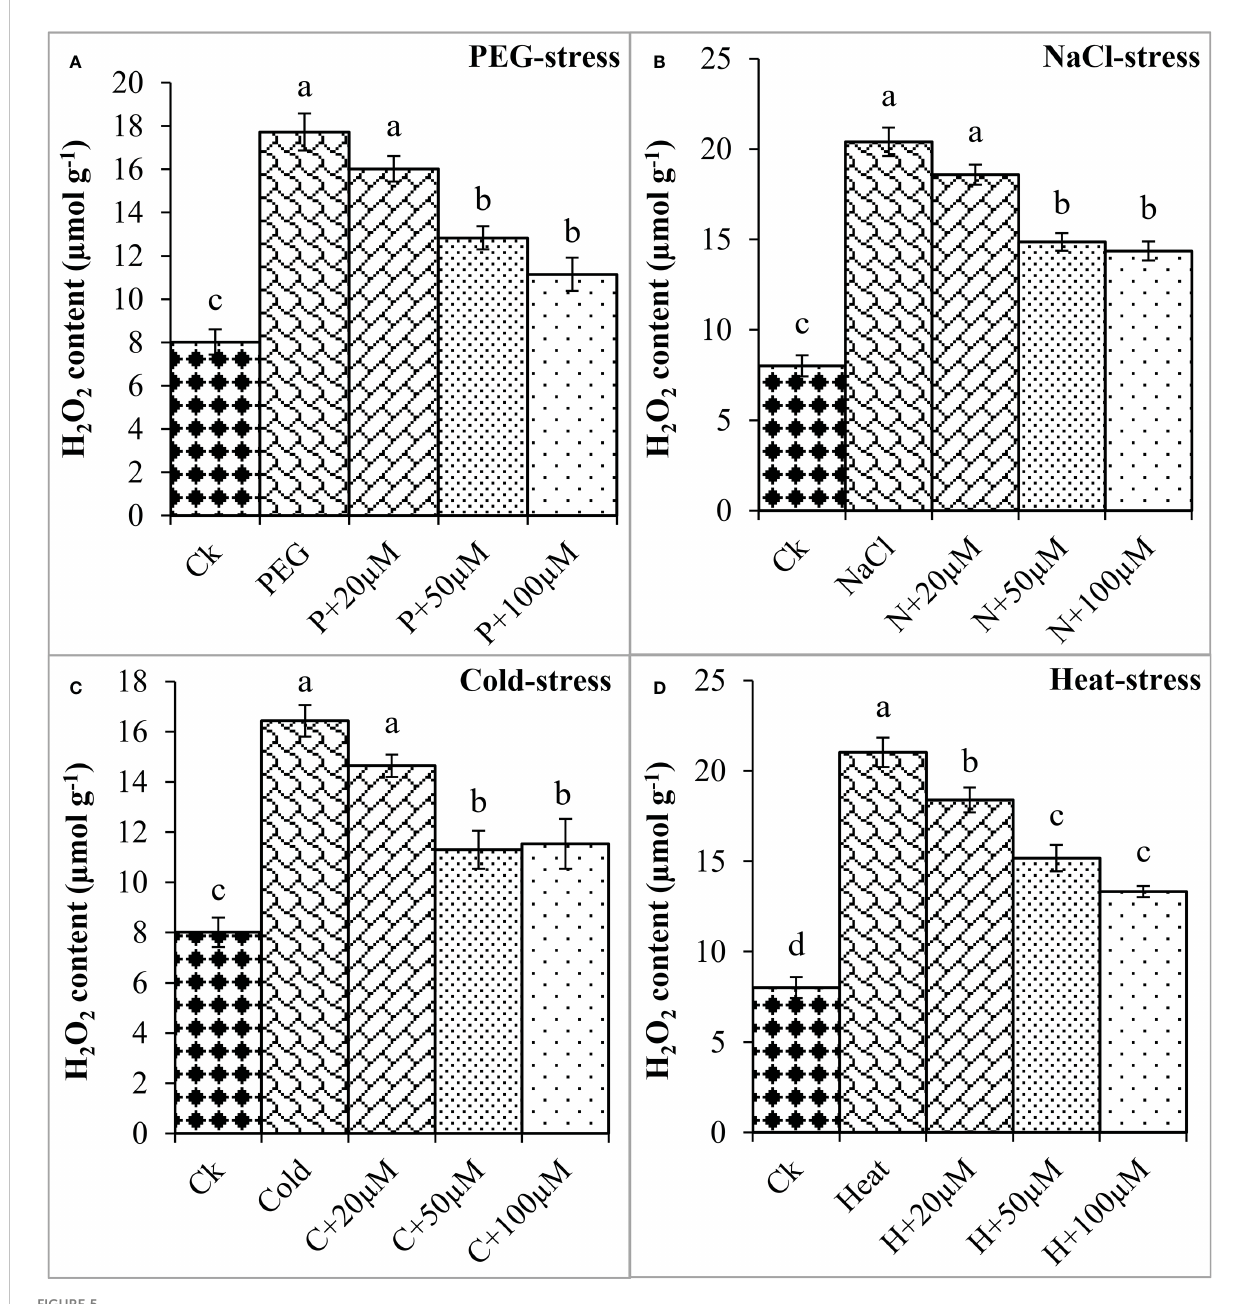
FIGURE 5 Effect of different concentrations of melatonin on the activity of H 2 O 2 under PEG (A) , NaCl (B) , Cold (C) , and Heat (D) . Values are the means ± SD (n=3). Different letters on the bars show a statistical signi fi cance level at p<0.05 . Here, µM is indicating (µmole L -1